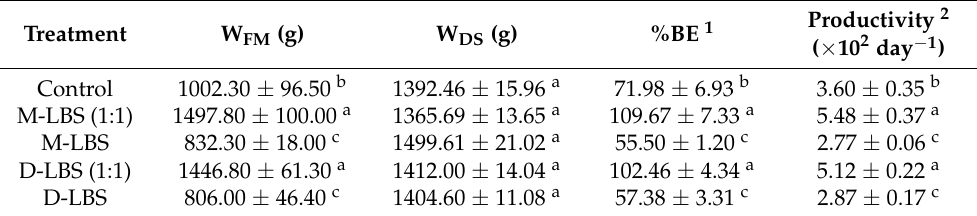
Table 2. The biological efficiency (%BE) and productivity of gray oyster mushroom cultivated on various treatments.